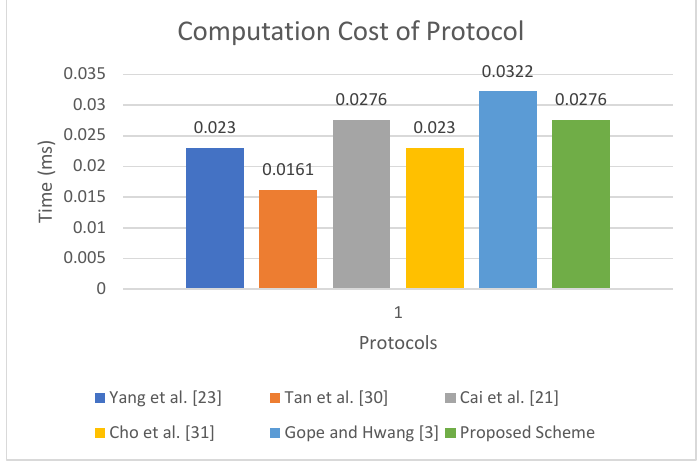
Figure 7. Running Time of Proposed